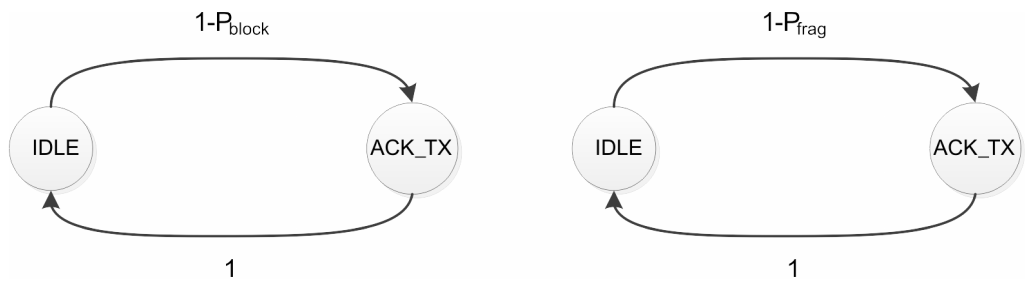
Figure 5. Blockwise transfer in observe data transaction. Two blocks compose each update. In the second update the CoAP ACK sent by the client fails while in the third one the second block fails. Both failures cause the retransmission of the relative